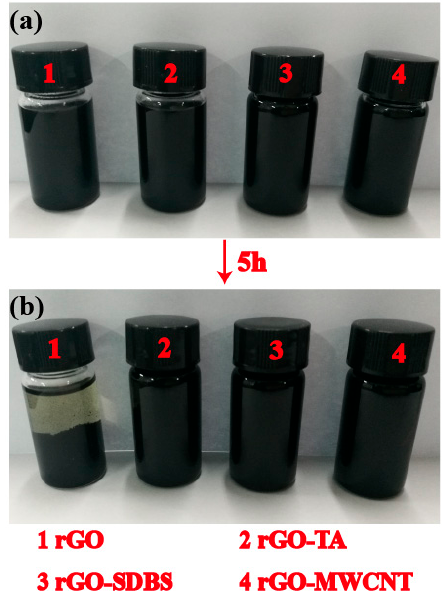
Figure A1. Photos of slurry after sonication at ( a ) 0 h and ( b ) 5 h (1—rGO, 2—GO–tannic acid (TA), 3—GO-SDBS, and 4—GO-MWCNT).